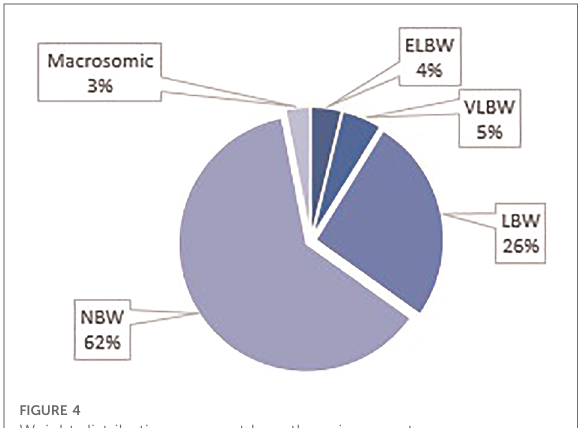
FIGURE 4 Weight distribution amongst hypothermic neonates.